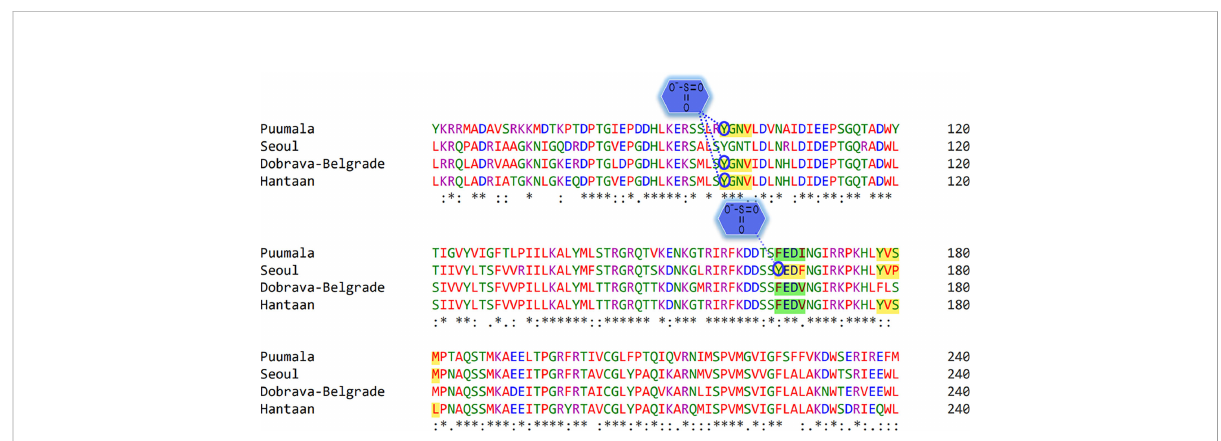
FIGURE 8 Representation of sulfonated sites within the YXX F [I/L/M/F/V] motifs of viral sequences. Stars, amino acid sequence similarity; colons, amino acid sequence